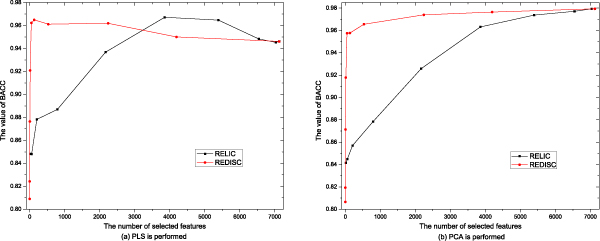
Comparative results of BACC scores by using different algorithms on the Leukemia data set.